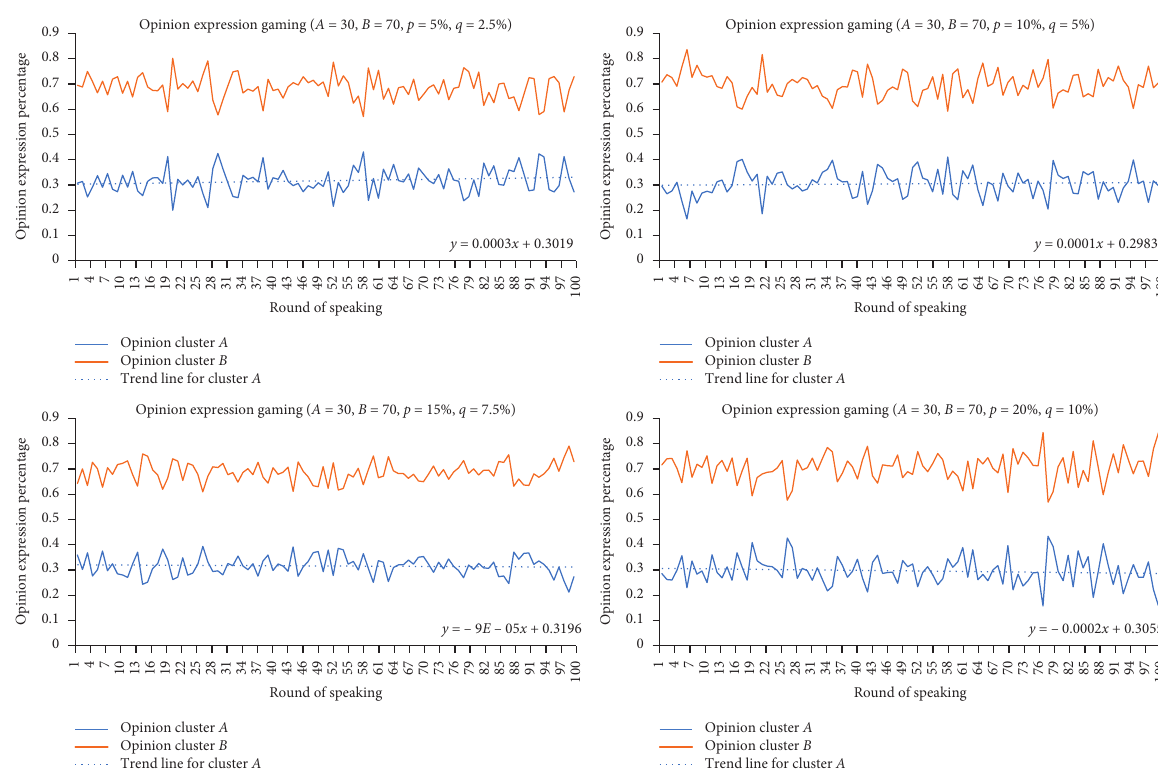
Figure 7: Minority/majority opinion expression. (For example, A � 30, B � 70). Note. Opinion expression percentage, with A (minority cluster) � blue thick line and B (majority cluster) � red thin line. Round of speaking represents time because each discussion allows 100 rounds of speaking. All the results were shown in the average score of 100 times’